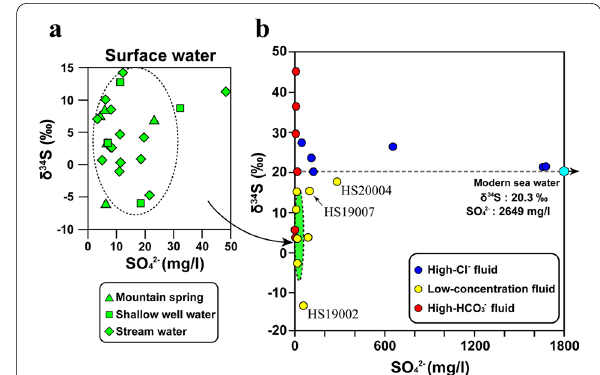
Fig. 5 SO 42 − concentration versus δ 34 S diagrams. a , b Sample plots for three types of groundwaters from hot spring sites, High-Cl − , Low-concentration, and High-HCO 3 − fluids, with comparison of those for surface waters. Compositions of modern sea water are after Rees et al.